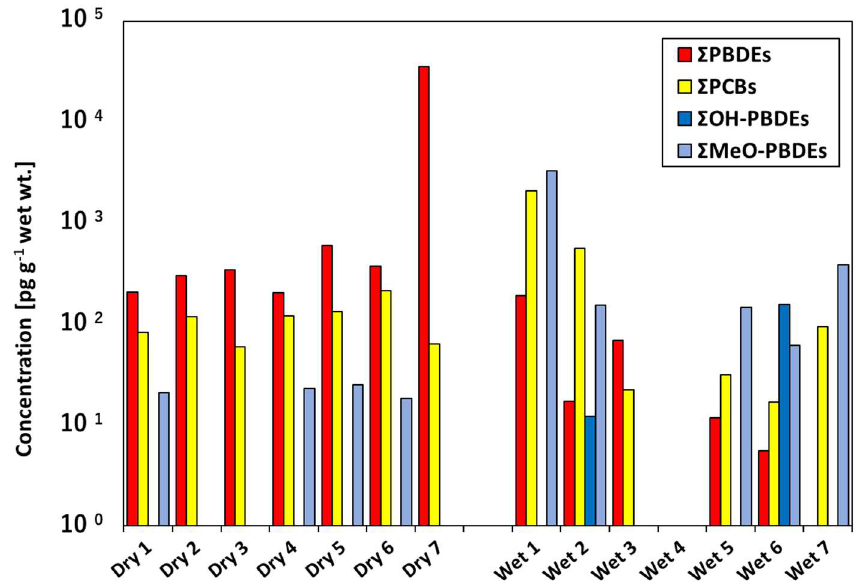
Figure 2. OHC concentrations in each dry and wet cat